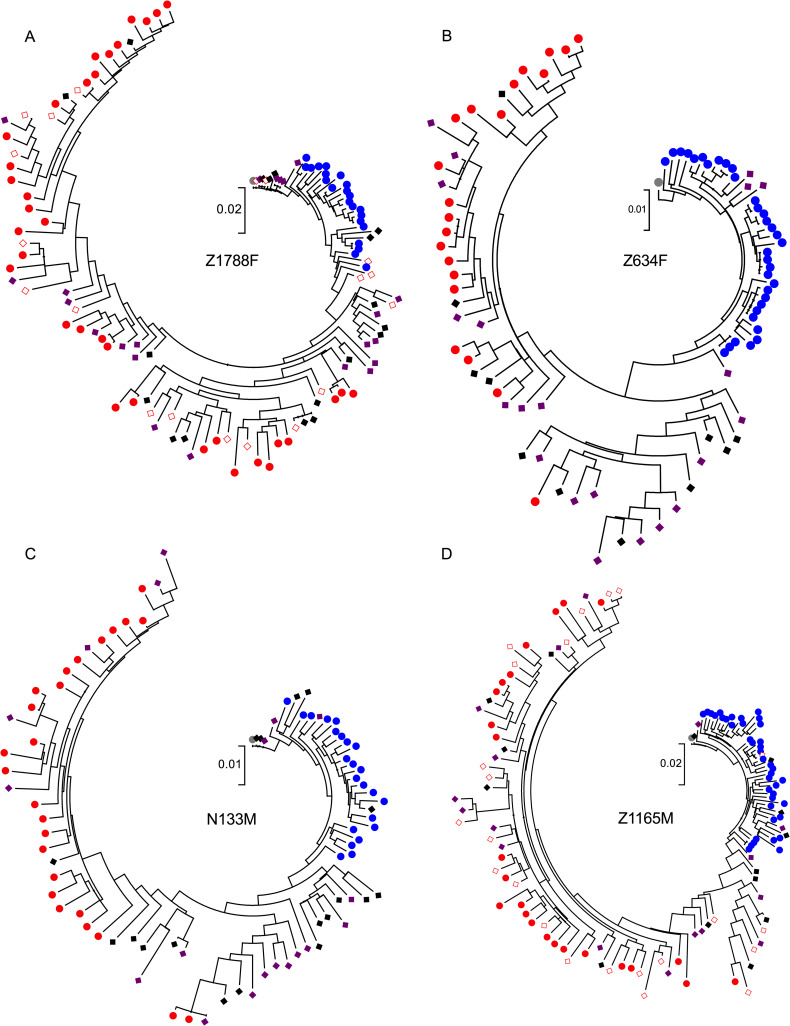
Maximum-likelihood (ML) trees of all variants for participants with two samples during treatment.ML phylogenetic trees for all four participants: Z1788F (A), Z634F (B), N133M (C), and Z1165M (D) rooted on the respective transmitted/founder virus (grey) and depicting all viral variants from one year post-infection (blue), the last ART-naïve sample (red), and during treatment (purple and black diamonds, with second sample in black). Sequences from cells collected at the last ART-naïve time point are in open red diamonds, while plasma sequences are depicted in circles.